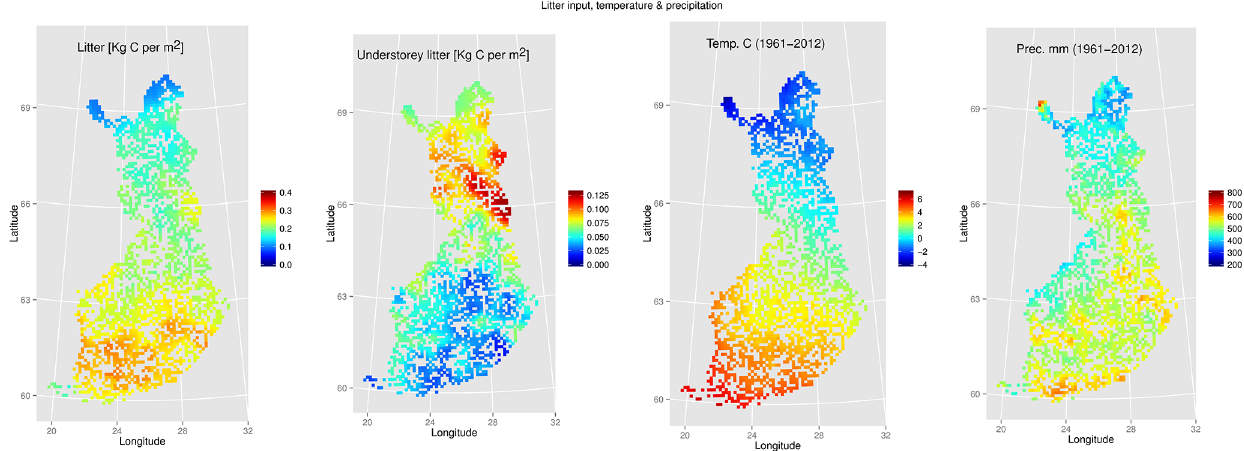
Figure 4. Maps for total litter input (Mgha − 1 ), understorey litter input (Mgha − 1 ), mean annual temperature ( ◦ C) and mean annual precipi- tation